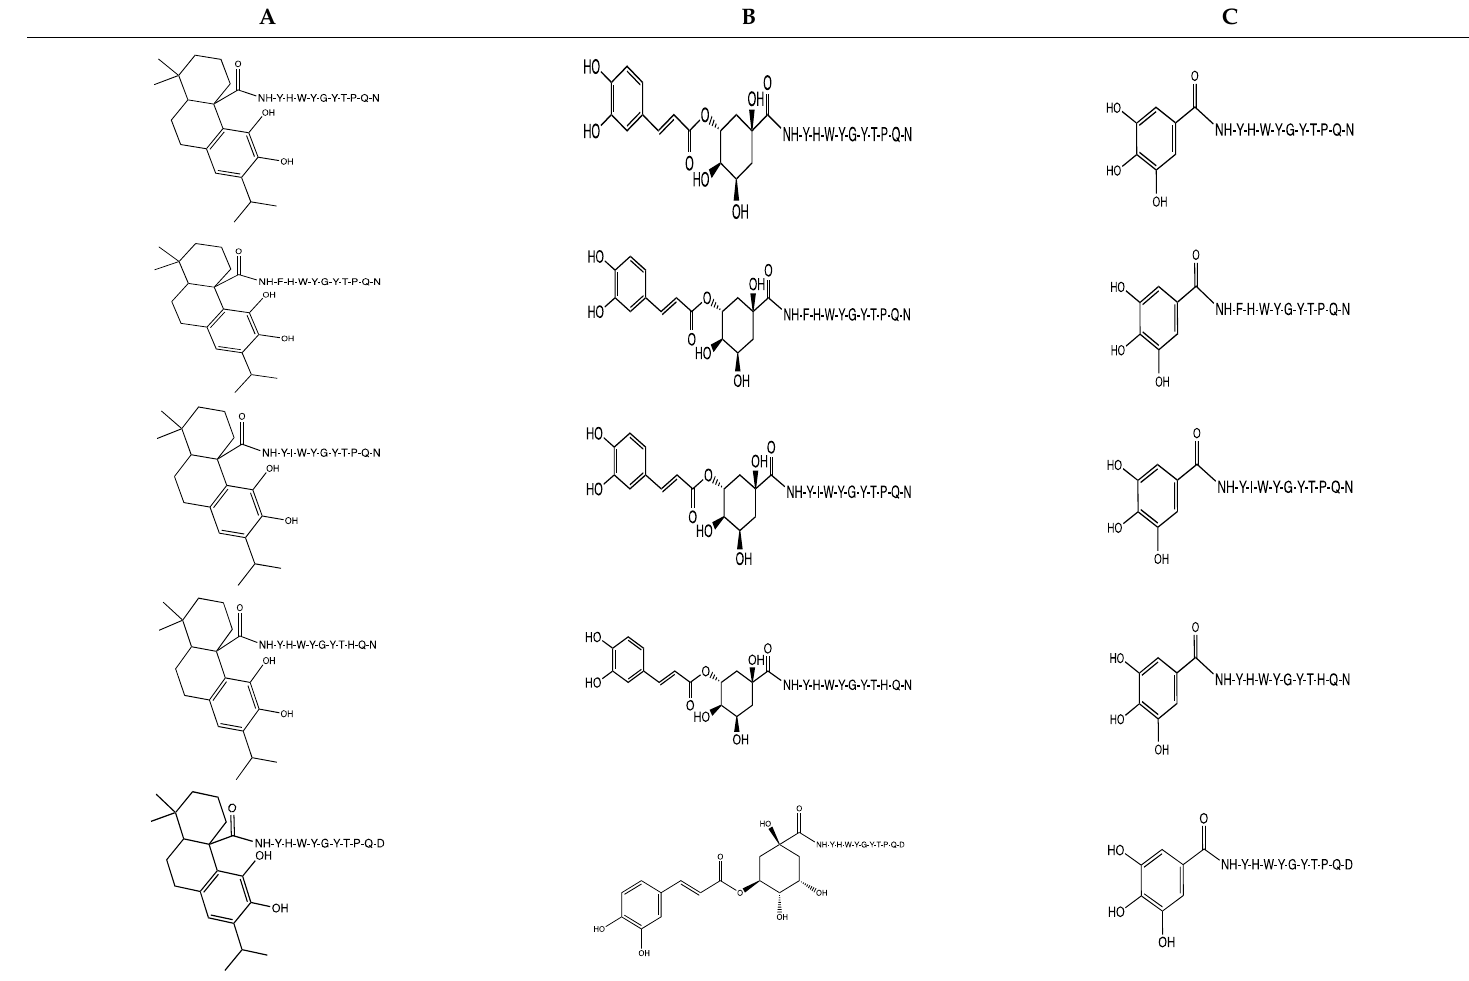
Table 2. Structures of Polyphenol-peptide Conjugates with Pep and Mut1-Mut4. Sequences from top to bottom. (Column A = carnosic amide derived conjugates; Table 2 . Structures of Polyphenol-peptide Conjugates with Pep and Mut1-Mut4. Sequences from top to bottom. (Column A = carnosic amide derived conjugates; Table 2 . Structures of Polyphenol-peptide Conjugates with Pep and Mut1-Mut4. Sequences from top to bottom. (Column A = carnosic amide derived conjugates; Table 2 . Structures of Polyphenol-peptide Conjugates with Pep and Mut1-Mut4. Sequences from top to bottom. (Column A = carnosic amide derived conjugates; Table 2 . Structures of Polyphenol-peptide Conjugates with Pep and Mut1-Mut4. Sequences from top to bottom. (Column A = carnosic amide derived conjugates; Column B = Chlorogenic amide conjugates; Column C = gallic amide onjugates and Column D = Rosmarinic amide derived conjugates). Table 2 . Structures of Polyphenol-peptide Conjugates with Pep and Mut1-Mut4. Sequences from top to bottom. (Column A = carnosic amide derived conjugates; Table 2 . Structures of Polyphenol-peptide Conjugates with Pep and Mut1-Mut4. Sequences from top to bottom. (Column A = carnosic amide derived conjugates; Table 2 . Structures of Polyphenol-peptide Conjugates with Pep and Mut1-Mut4. Sequences from top to bottom. (Column A = carnosic amide derived conjugates; Table 2 . Structures of Polyphenol-peptide Conjugates with Pep and Mut1-Mut4. Sequences from top to bottom. (Column A = carnosic amide derived conjugates; Table 2 . Structures of Polyphenol-peptide Conjugates with Pep and Mut1-Mut4. Sequences from top to bottom. (Column A = carnosic amide derived conjugates; Table 2 . Structures of Polyphenol-peptide Conjugates with Pep and Mut1-Mut4. Sequences from top to bottom. (Column A = carnosic amide derived conjugates; Table 2 . Structures of Polyphenol-peptide Conjugates with Pep and Mut1-Mut4. Sequences from top to bottom. (Column A = carnosic amide derived conjugates; Table 2 . Structures of Polyphenol-peptide Conjugates with Pep and Mut1-Mut4. Sequences from top to bottom. (Column A = carnosic amide derived conjugates; Table 2 . Structures of Polyphenol-peptide Conjugates with Pep and Mut1-Mut4. Sequences from top to bottom. (Column A = carnosic amide derived conjugates; Table 2 . Structures of Polyphenol-peptide Conjugates with Pep and Mut1-Mut4. Sequences from top to bottom. (Column A = carnosic amide derived conjugates; Table 2 . Structures of Polyphenol-peptide Conjugates with Pep and Mut1-Mut4. Sequences from top to bottom. (Column A = carnosic amide derived conjugates; Table 2 . Structures of Polyphenol-peptide Conjugates with Pep and Mut1-Mut4. Sequences from top to bottom. (Column A = carnosic amide derived conjugates; Column B = Chlorogenic amide conjugates; Column C = gallic amide onjugates and Column D = Rosmarinic amide derived conjugates). Column B = Chlorogenic amide conjugates; Column C = gallic amide onjugates and Column D = Rosmarinic amide derived conjugates). Column B = Chlorogenic amide conjugates; Column C = gallic amide onjugates and Column D = Rosmarinic amide derived conjugates). Column B = Chlorogenic amide conjugates; Column C = gallic amide onjugates and Column D = Rosmarinic amide derived conjugates). Column B = Chlorogenic amide conjugates; Column C = gallic amide onjugates and Column D = Rosmarinic amide derived conjugates). Column B = Chlorogenic amide conjugates; Column C = gallic amide onjugates and Column D = Rosmarinic amide derived conjugates). Column B = Chlorogenic amide conjugates; Column C = gallic amide onjugates and Column D = Rosmarinic amide derived conjugates). Column B = Chlorogenic amide conjugates; Column C = gallic amide onjugates and Column D = Rosmarinic amide derived conjugates). Column B = Chlorogenic amide conjugates; Column C = gallic amide onjugates and Column D = Rosmarinic amide derived conjugates). Column B = Chlorogenic amide conjugates; Column C = gallic amide onjugates and Column D = Rosmarinic amide derived conjugates). Column B = Chlorogenic amide conjugates; Column C = gallic amide onjugates and Column D = Rosmarinic amide derived conjugates). Column B = Chlorogenic amide conjugates; Column C = gallic amide onjugates and Column D = Rosmarinic amide derived conjugates). Column B = Chlorogenic amide conjugates; Column C = gallic amide onjugates and Column D = Rosmarinic amide derived conjugates). Column B = Chlorogenic amide conjugates; Column C = gallic amide onjugates and Column D = Rosmarinic amide derived conjugates). Column B = Chlorogenic amide conjugates; Column C = gallic amide onjugates and Column D = Rosmarinic amide derived conjugates). Column B = Chlorogenic amide conjugates; Column C = gallic amide onjugates and Column D = Rosmarinic amide derived conjugates). A B C D A B C D A B C D A B C D A B C D A B C D A B C D A B C D A B C D A B C D A B C D A B C D A B C D A B C D A B C D A B C D A B